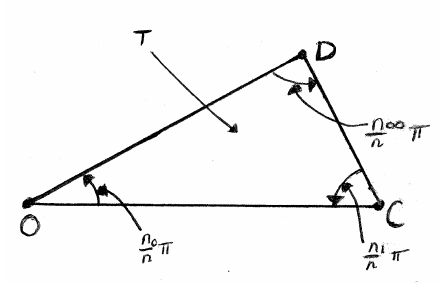
Figure 1. The rational triangle T = T n